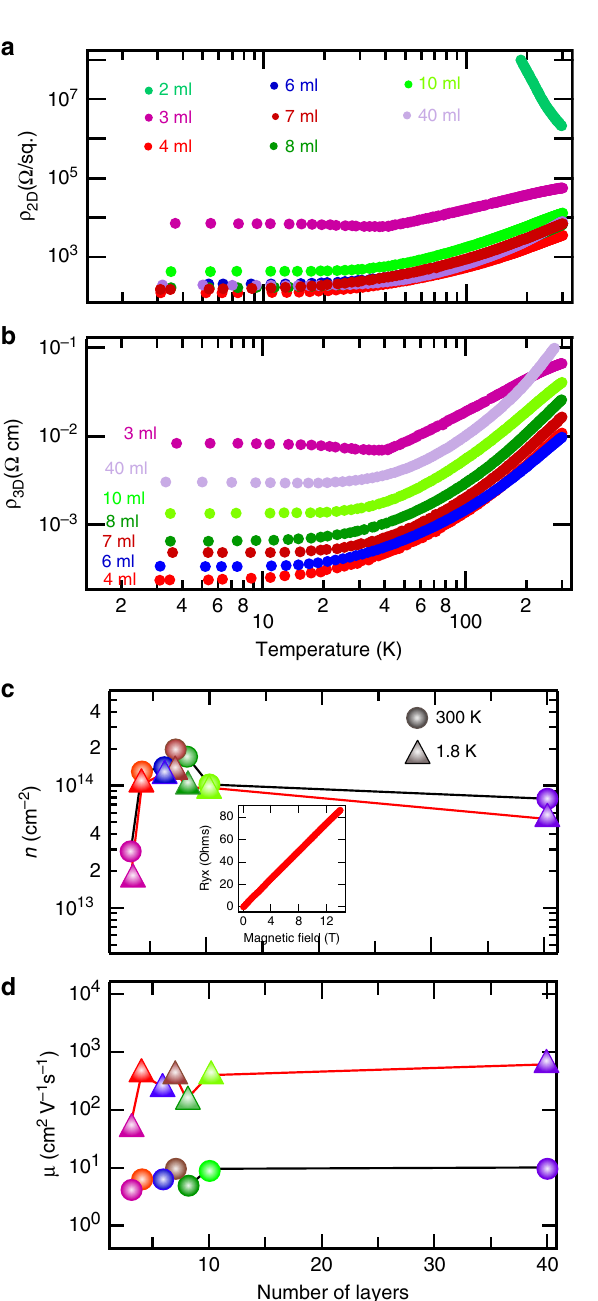
Fig. 2 Electrical properties. (Color online) a Temperature dependent 2D resistivity and b 3D resistivity for LVO-KTO samples with varying LVO thickness. c Charge carrier density and d mobility of all the samples measured at 300 K and 1.8 K. Inset of b shows the Hall data for 4 ml sample at 1.8 K.